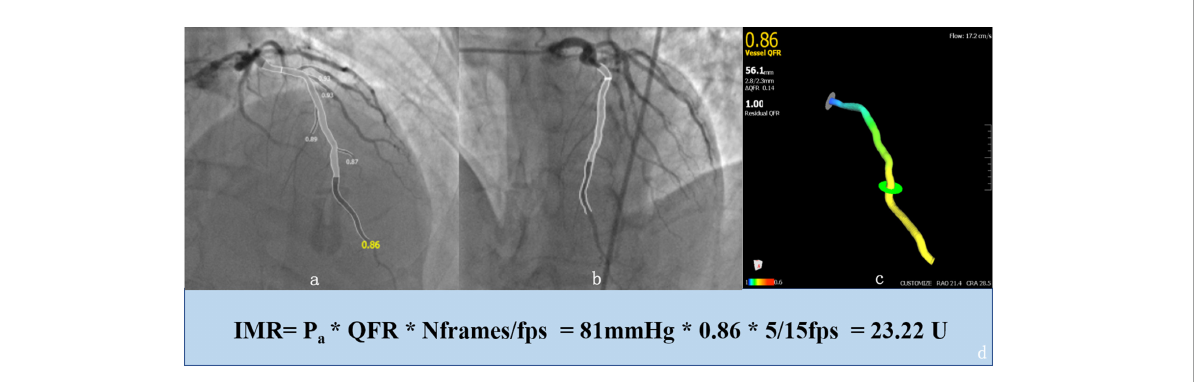
FIGURE1 Example of an enrolled 65-year-old patient who was analyzed with the AngioPlus System to obtain the value of the quantitative flow ratio (QFR) and derivation of the angiography-based index of microcirculatory resistance (IMRangio). First, we obtained a 3D anatomical vessel model without its side branches (c) for the computation of the QFR by two angiographic images with different angles ( ≥ 25 ◦ ) and minimal vessel overlap (a,b) . Second, the value of IMRangio was derived according to the mean baseline aortic pressure (Pa), the number of frames for contrast dye traveling from the tip of the guiding catheter to the distal reference (Nframes) and the value of the QFR (d) .